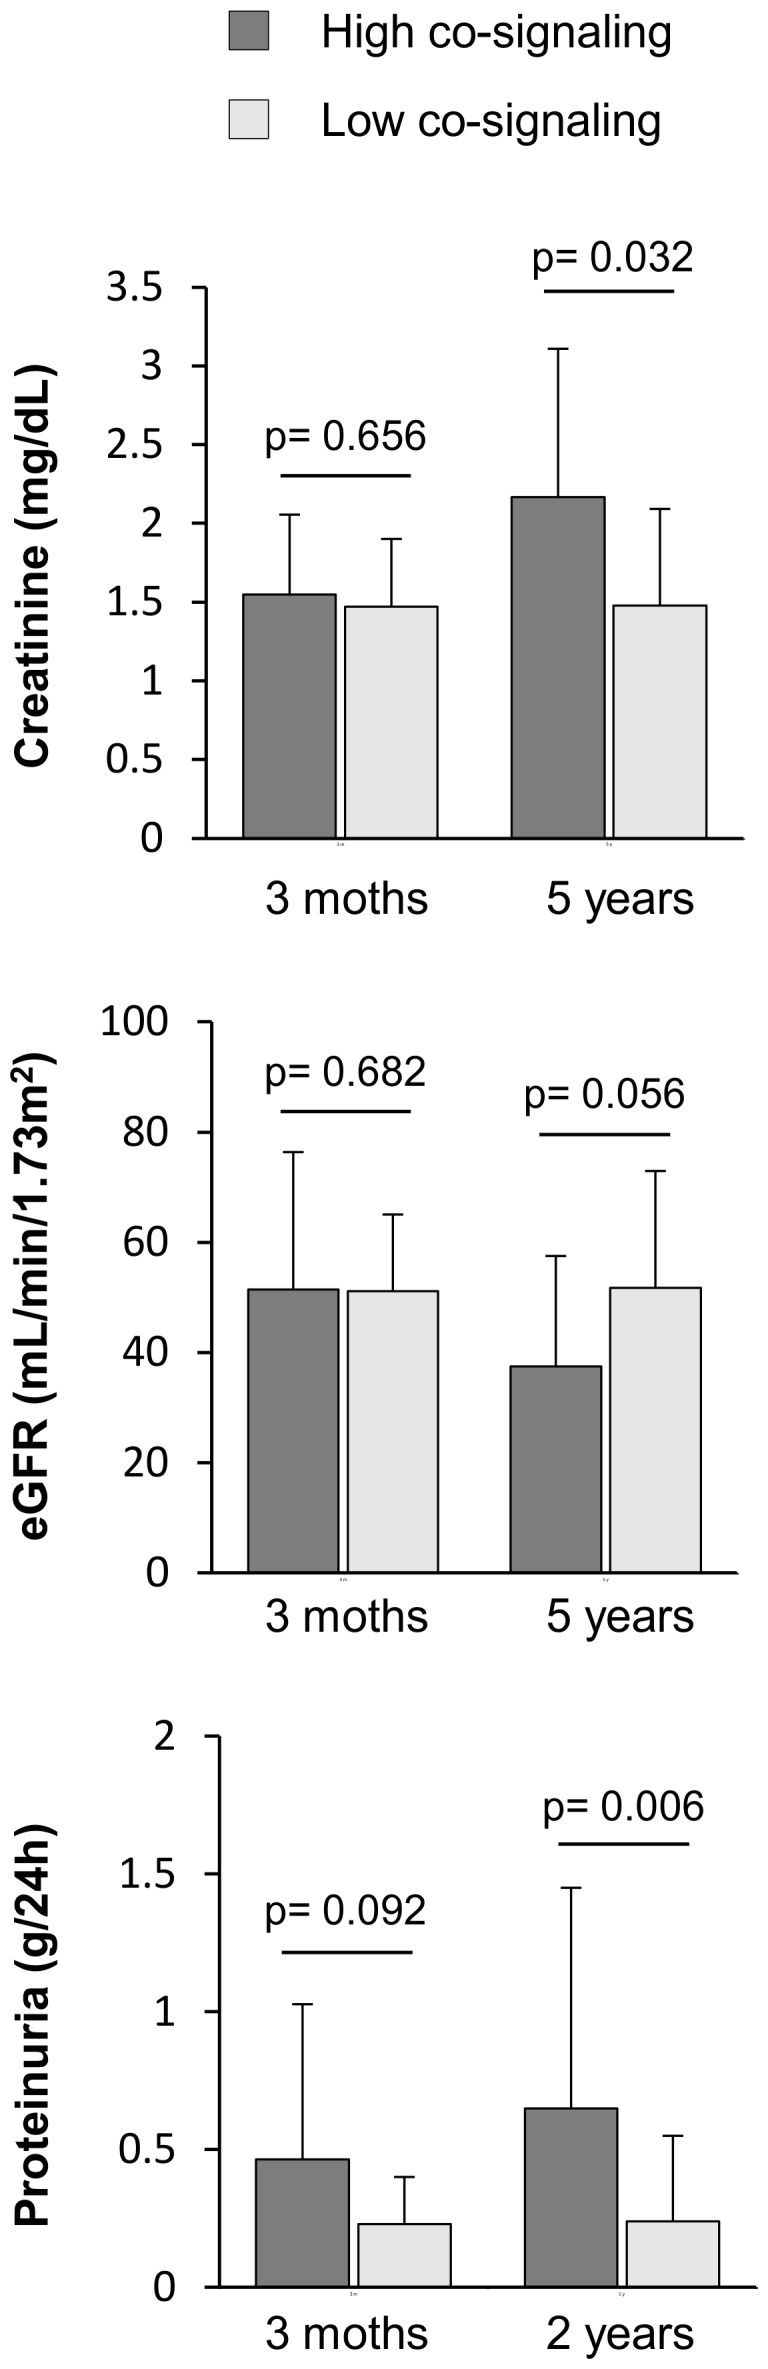
Changes of the creatinine, estimated glomerular filtration rate (eGFR) and proteinuria levels over time in kidney-transplanted patients grouped by the levels of soluble co-signaling molecules.Patients were clustered according to the levels of soluble co-signaling molecules quantified at 3 months post-transplantation in high co-signaling and low co-signaling groups. The levels of creatinine, eGFR and proteinuria did not differ between these two groups at time the soluble molecules were quantified. At 5 years post-transplantation, patients in the high co-signaling group showed an increase in creatinine levels and a decrease in the eGFR, whilst the characteristics of the patients in the low co-signaling group were unchanged. Changes in the proteinuria levels between both groups were observed by the second year post-transplantation.